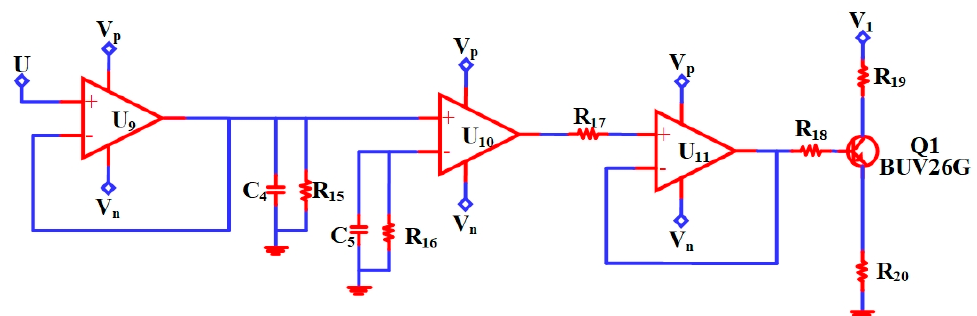
Figure 6. Amplifying matching circuit schematic diagram.